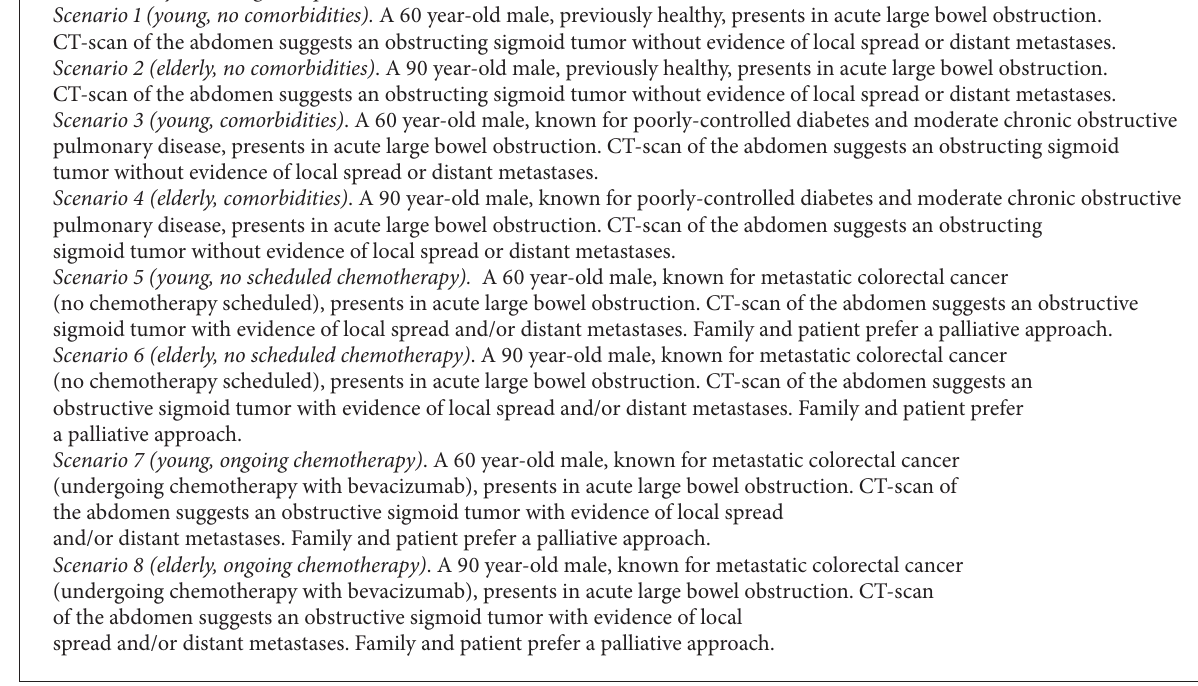
Box 1: Clinical scenarios of different cases of malignant large bowel